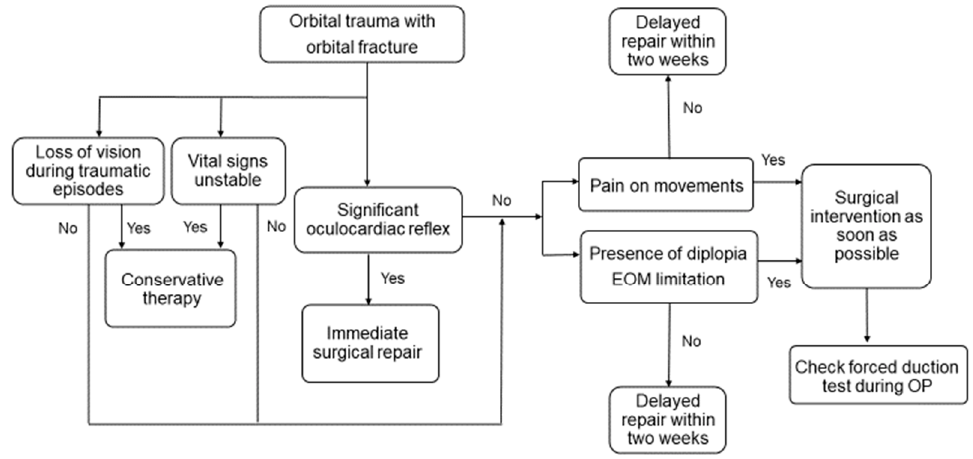
Figure 1. Algorithm for the early management of a blowout fracture. Abbreviations: EOM, extraocu- lar movement; OP,